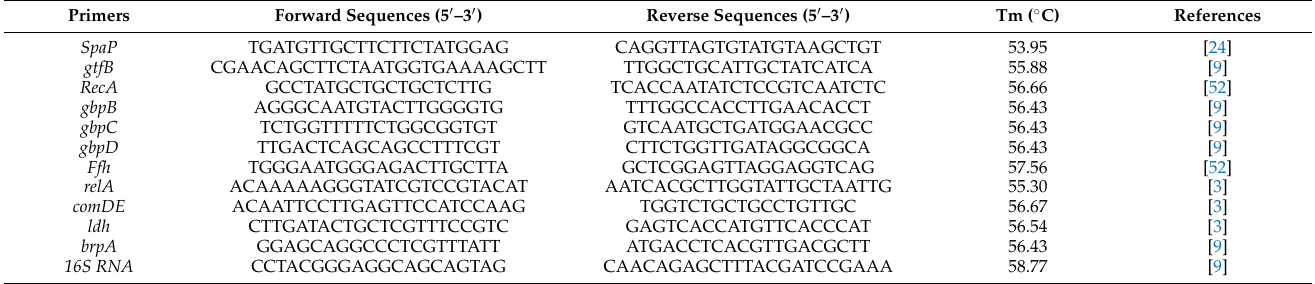
Table 4. The table of primer